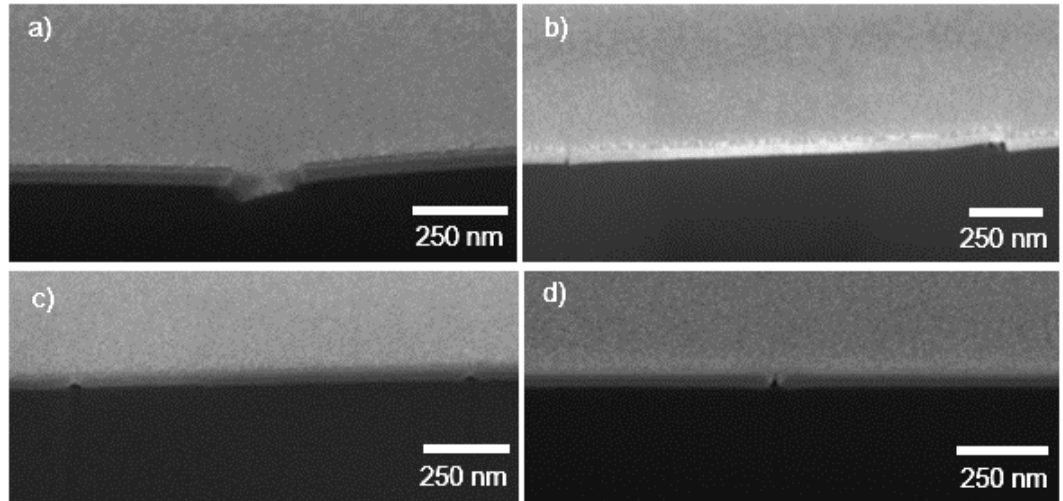
Figure 5. SEM images of focused Ga-ion beam (FIB) cut cross-sections (52° angle) of atomic layer deposition (ALD) films on polyimide. ( a ) Al 2 O 3 220 °C, ( b ) ZnO, ( c ) ZrO 2 on Al 2 O 3 , and ( d ) Y 2 O 3 samples. No sub-surface growth into the polyimide was observed.